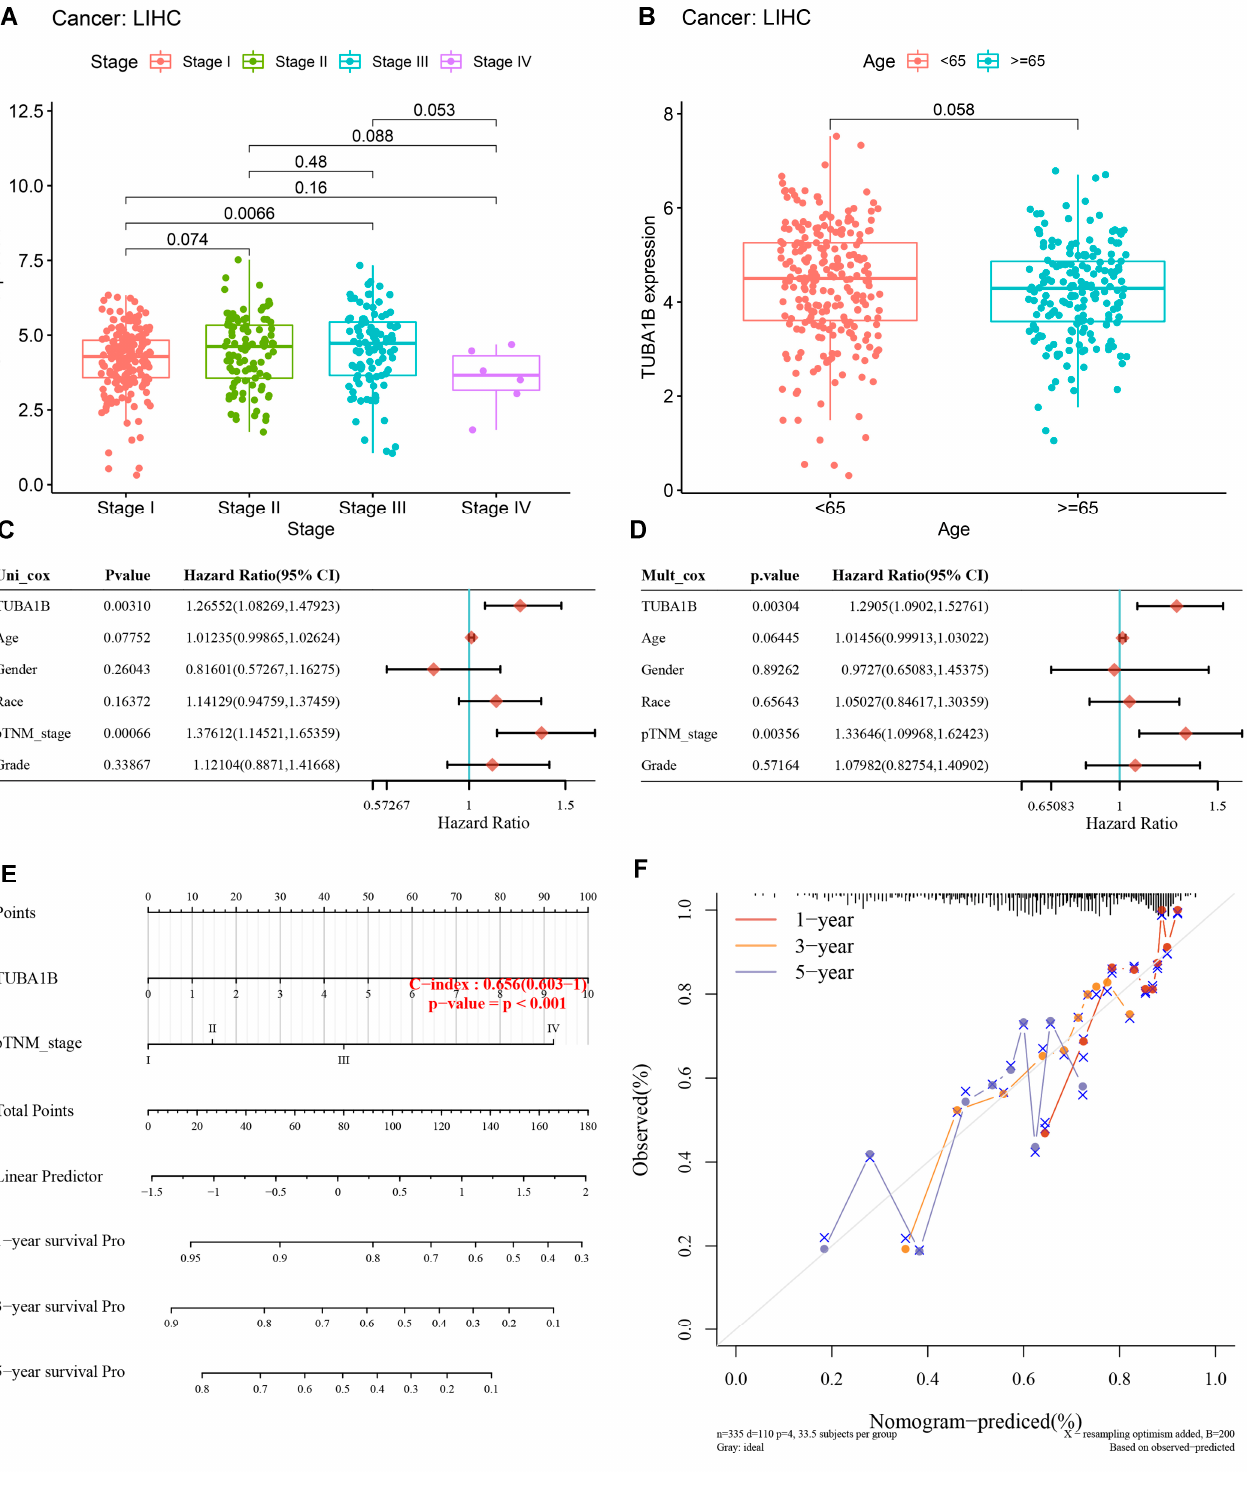
Figure 3. The relationship of clinicopathology with TUBA1B in HCC and the prognostic value of TUBA1B. ( A ) TUBA1B expression in different stages of HCC. ( B ) TUBA1B expression in age < 65 and age ≥ 65 of HCC. The univariate ( C ) and multivariate ( D ) Cox analysis of TUBA1B, age, gender, race, pTNM_stage, and grade. ( E ) The nomogram of TUBA1B and pTNM_stage was constructed to predict 1-, 3-, and 5-year OS in LIHC patients. ( F ) Calibration curves of the nomogram. Circles and cross are the actual observed mortality rates and 95% CI.